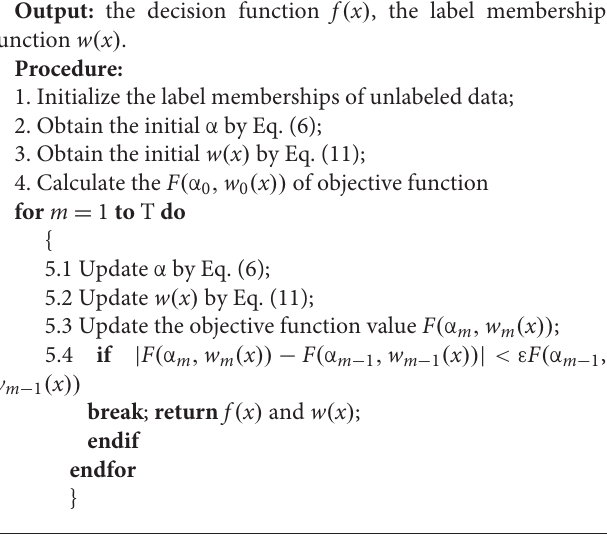
ALGORITHM DESCRIPTION OF